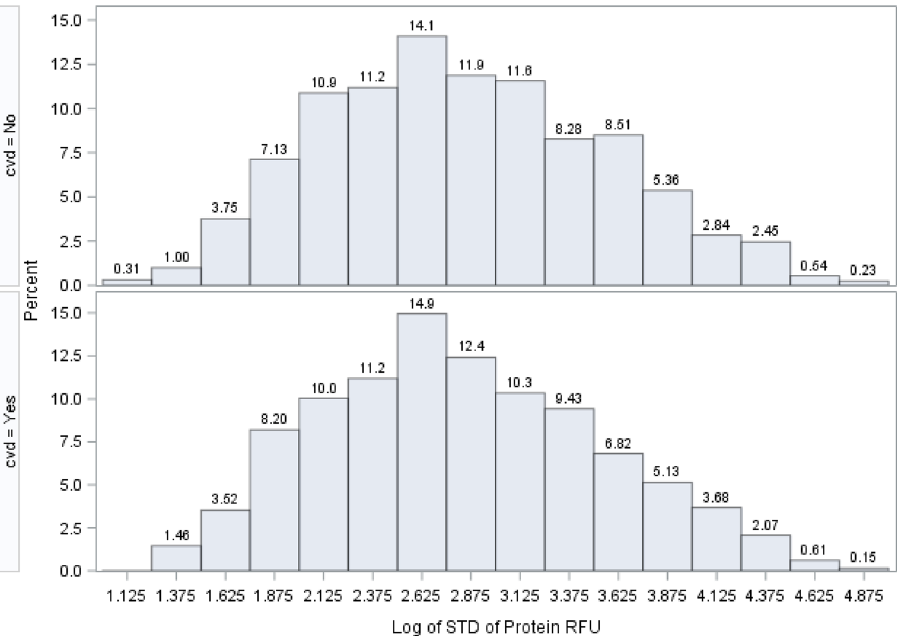
Figure 3. Distribution of the log base 10 of 1305 standard deviation estimates from 1305 Proteins.